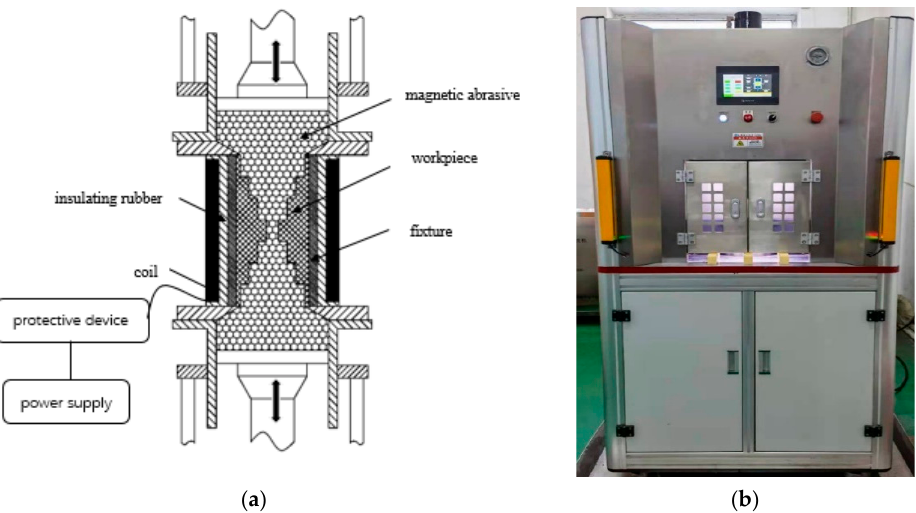
Figure 3. Processing method and experimental equipment diagram. ( a ) Schematic diagram of processing method; ( b ) Laboratory equipment.